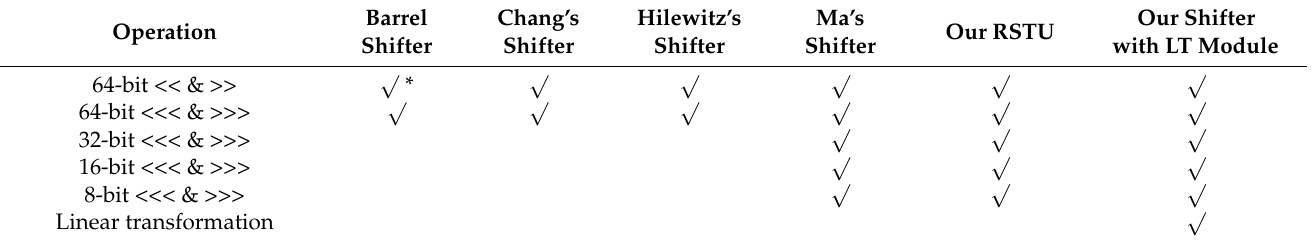
Table 1. Operations are supported by the shifters.